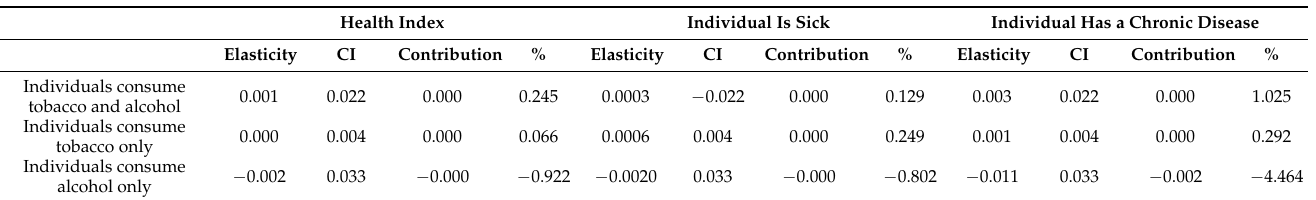
Table 6. The combined contribution of tobacco and alcohol consumption to income-related inequali- ties in